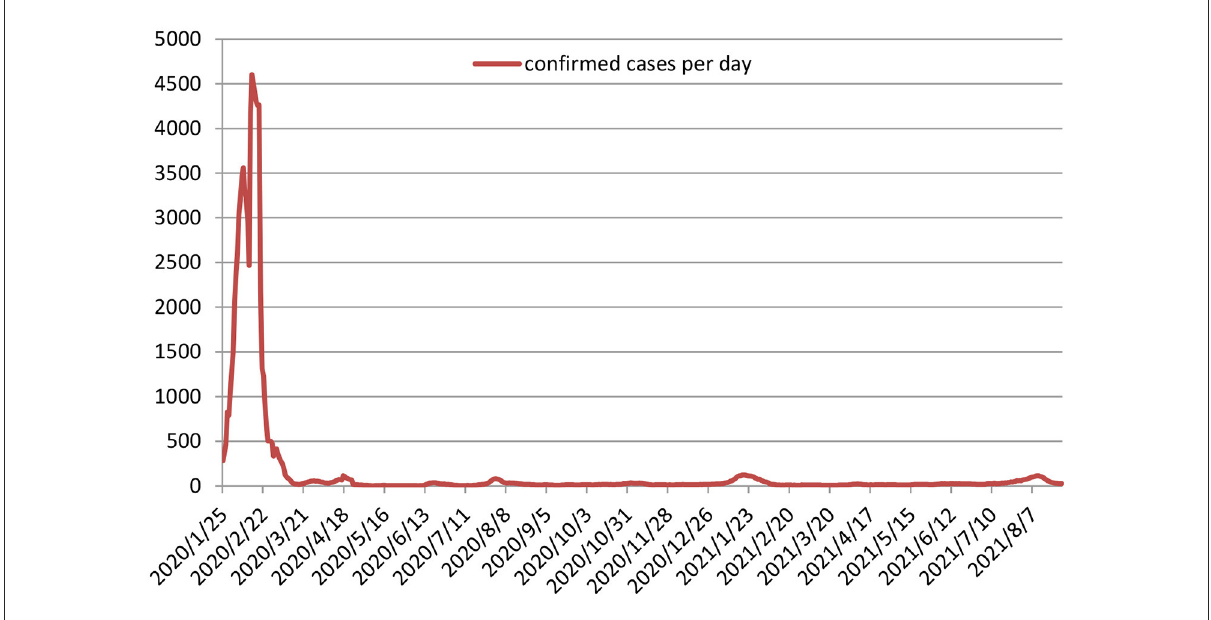
FIGURE1 The number of daily confirmed COVID-19 cases in